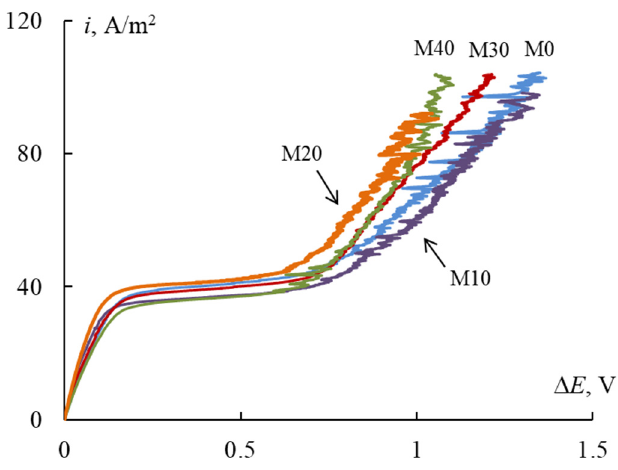
Figure 6. CV-curves for investigated membranes. Table 3. Parameters of CV-curves for investigated membranes.